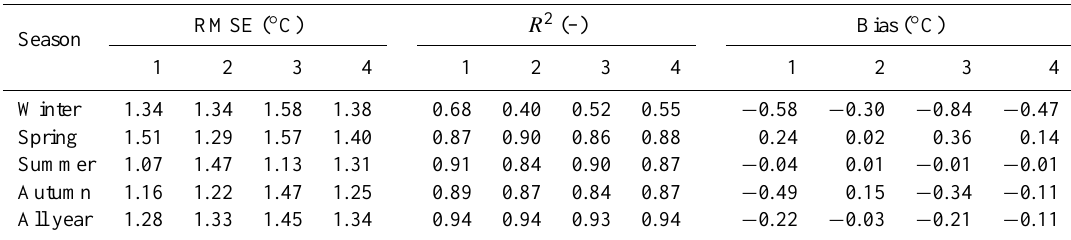
Table 5. Performance of the best physics-inspired statistical model in each season ( w i = 1) in terms of RMSE, R 2 and bias, depending on the validation set. The numbers between brackets refer to the different validation sets (see beginning of Sect. 4).